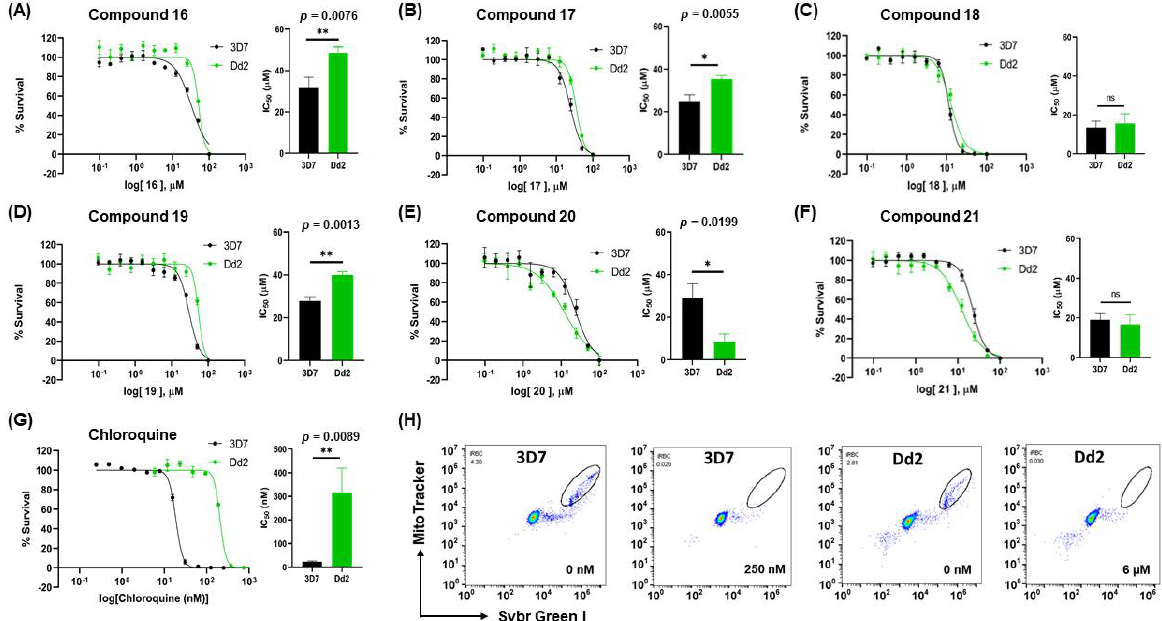
Figure 1. Determination of the antiplasmodial activity of 2-sulfenyl indoles in the 3D7 and Dd2 strains. Asynchronous parasites were exposed to compounds 16 , 17 , 18 , 19 , 20 , and 21 for 72 h in concentrations ranging from 0.1 to 100 µ M. Parasitemia was calculated using a flow cytometer by double staining parasites with SYBR and MitoTracker. Dot plot analysis of each drug concentration tested allowed us to determine parasitemia. Growth survival curves of blood-stage P. falciparum of compounds 16 ( A ), 17 ( B ), 18 ( C ), 19 ( D ), 20 ( E ), and 21 ( F ) for 3D7 (black) or Dd2 (green). Chloroquine ( G ) was administered at concentrations from 0 to 250 nM to 3D7 parasites and from 0 to 6 µ M to Dd2 parasites. Data represent three independent experiments performed in triplicate. ( H ) Dot plots representing SG-I/MT-Red staining of control and chloroquine-treated asynchronous 3D7 (left) and Dd2 (right) parasites after 72 h of treatment. The bar graphs represent the SD. Statistical significance was calculated using Student’s t-test: ns = not significant, * p ≤ 0.05, ** p ≤ 0.01.